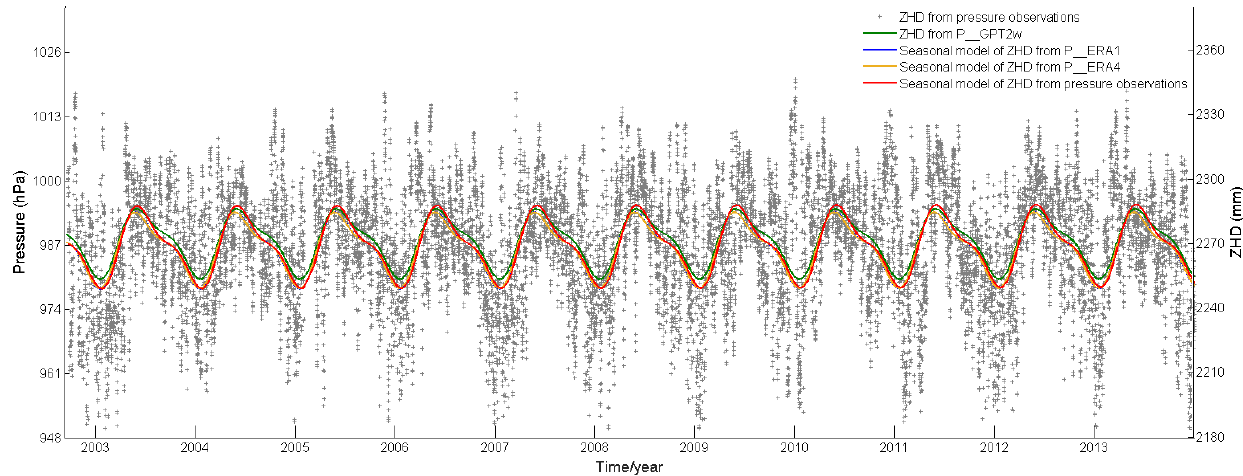
Figure 5. Comparison among the ZHD derived from P_GPT2w and seasonal models (annual and semiannual cycles) estimated from P_ERA1, P_ERA4 and pressure observations at station QAQ1 (60.8 ◦ N, 45.1 ◦ W).